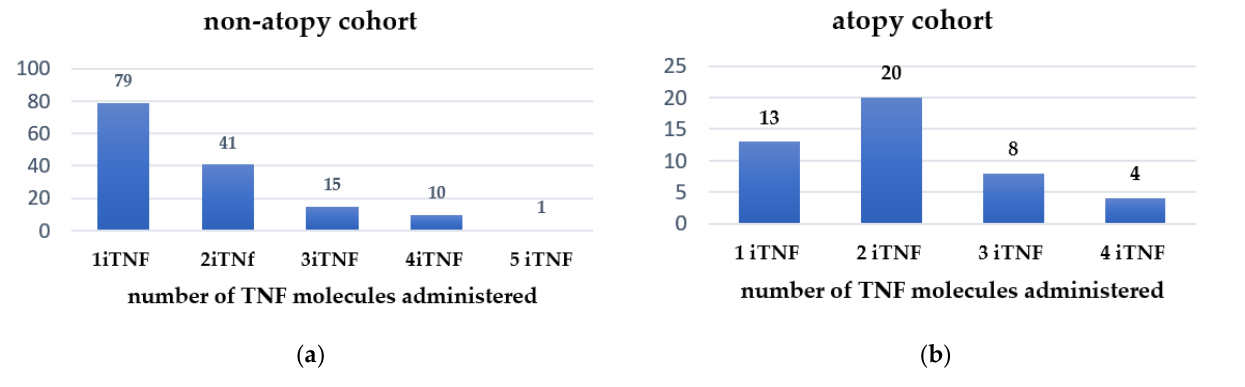
Figure 4. Number of TNF inhibitors used to treat SpA patients: ( a ) non-atopic cohort; ( b ) atopic cohort. Table 4. Distribution of patients according to the number of TNF inhibitors switched. Number of Patients Treated with TNF Inhibitors and Number of TNF Needed